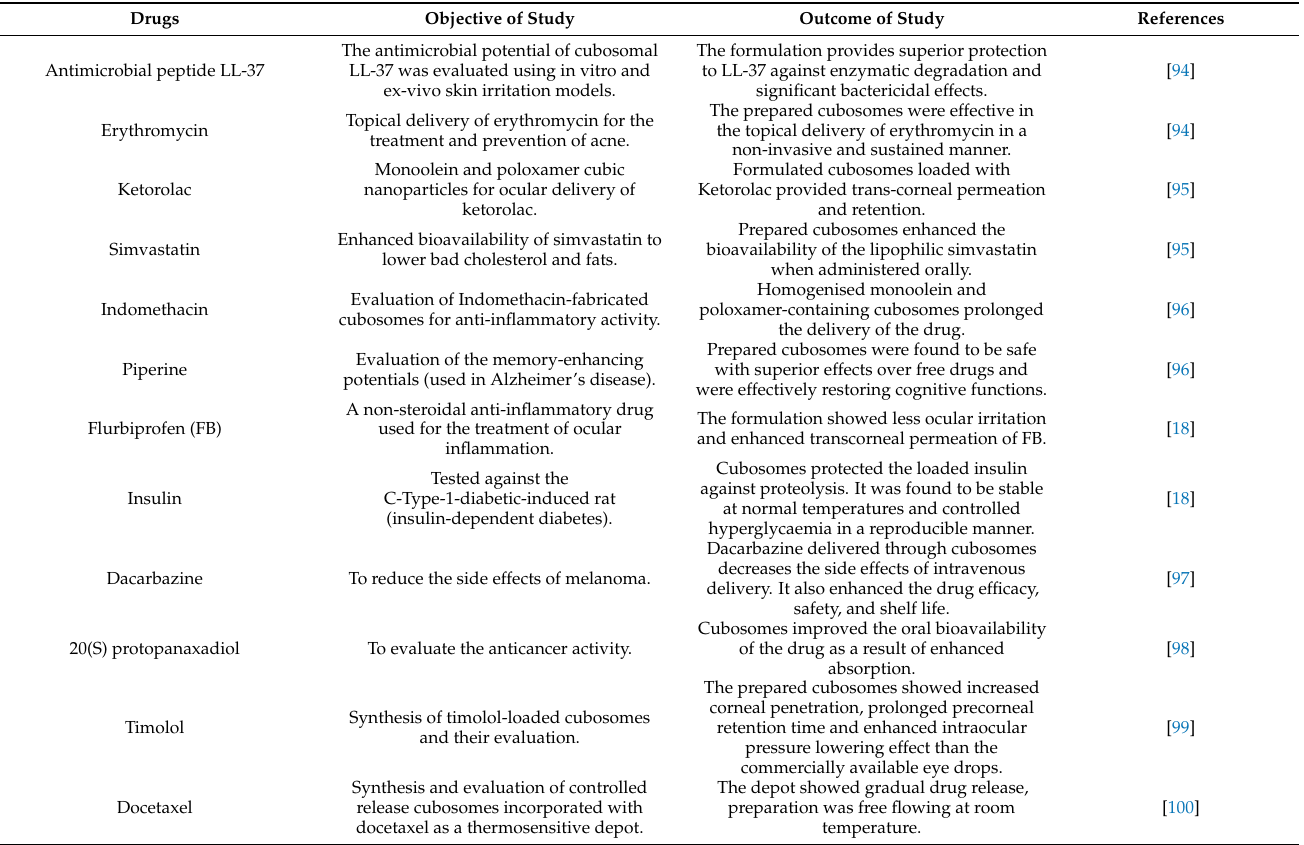
Table 11. Examples of drugs embedded in cubosomes and the outcome of the